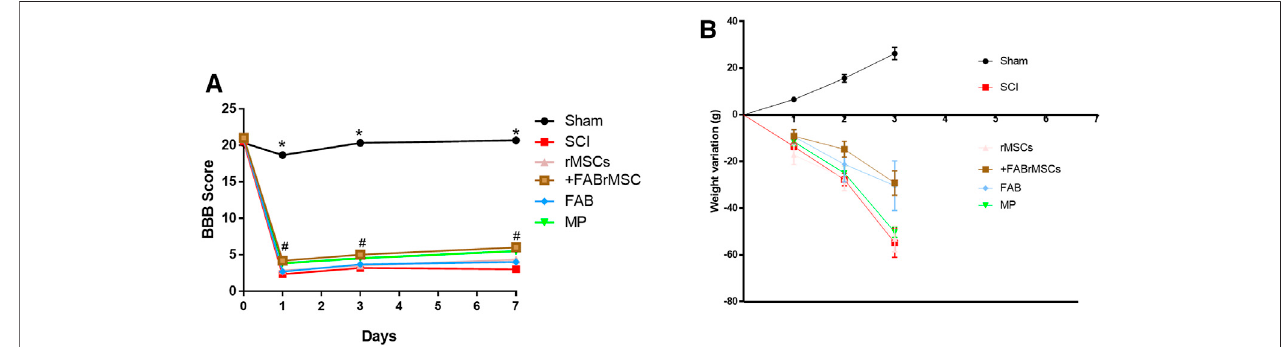
FIGURE 4 | Behavioral outcomes in animals subjected to spinal cord injury (SCI). (A) Motor function assessment based on the Basso, Beattie, Bresnahan scale (BBB) on day zero (before SCI), day 1, day 3 and day 7 after SCI. Adult male Wistar rats ( n = 6/group) underwent acute SCI and after 4 h were treated with a single application of 1 × 10 6 control rMSCs or 1 × 10 6 rMSCs pretreated with agathis fl avone (+FABrMSCs), treated with one single dose of methylprednisolone (60 mg/kg i.p., MP), or treated daily with agathis fl avone (10 mg/kg i. p., FAB) (#) p ≤ 0.05 vs. SCI rats. Data are the means ± SD (B) Weight variations of animals with SCI and different treatments.